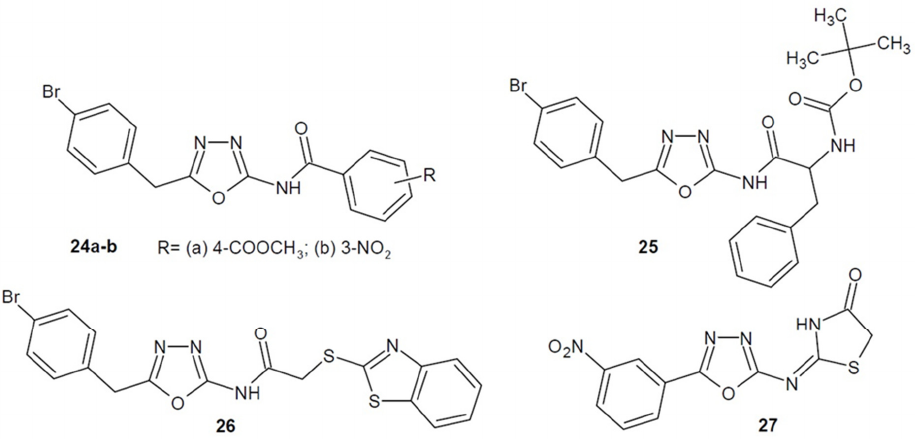
Figure 10. Amino-1,3,4-oxadiazole derivatives with antibacterial activity (part 2).